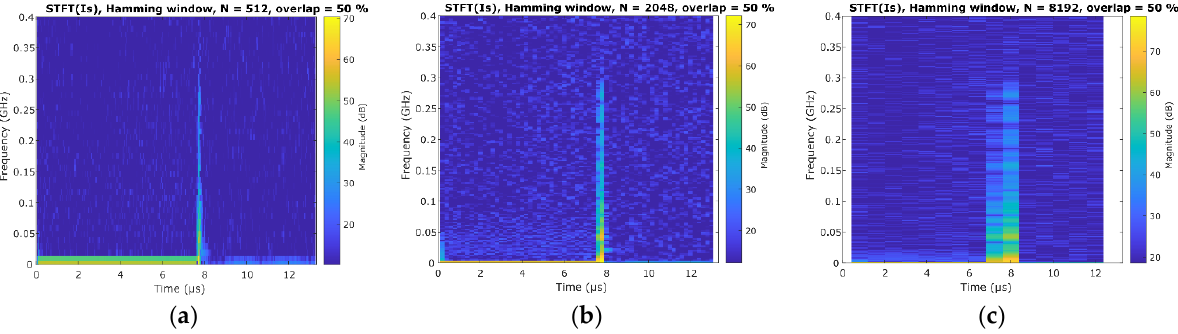
Figure 7. Time resolution vs. frequency resolution in STFT calculation for different length Hamming